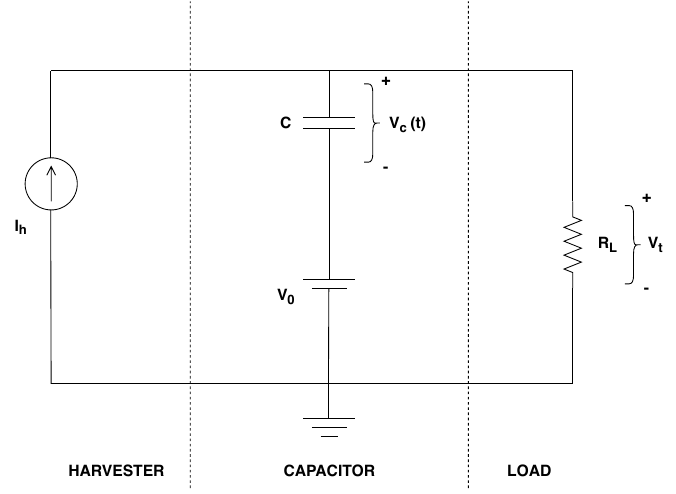
Figure 2. Electrical circuit model of a battery-less IoT